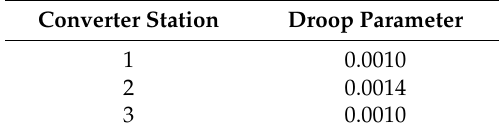
Table A17. Changes in the droop parameters of each converter station.